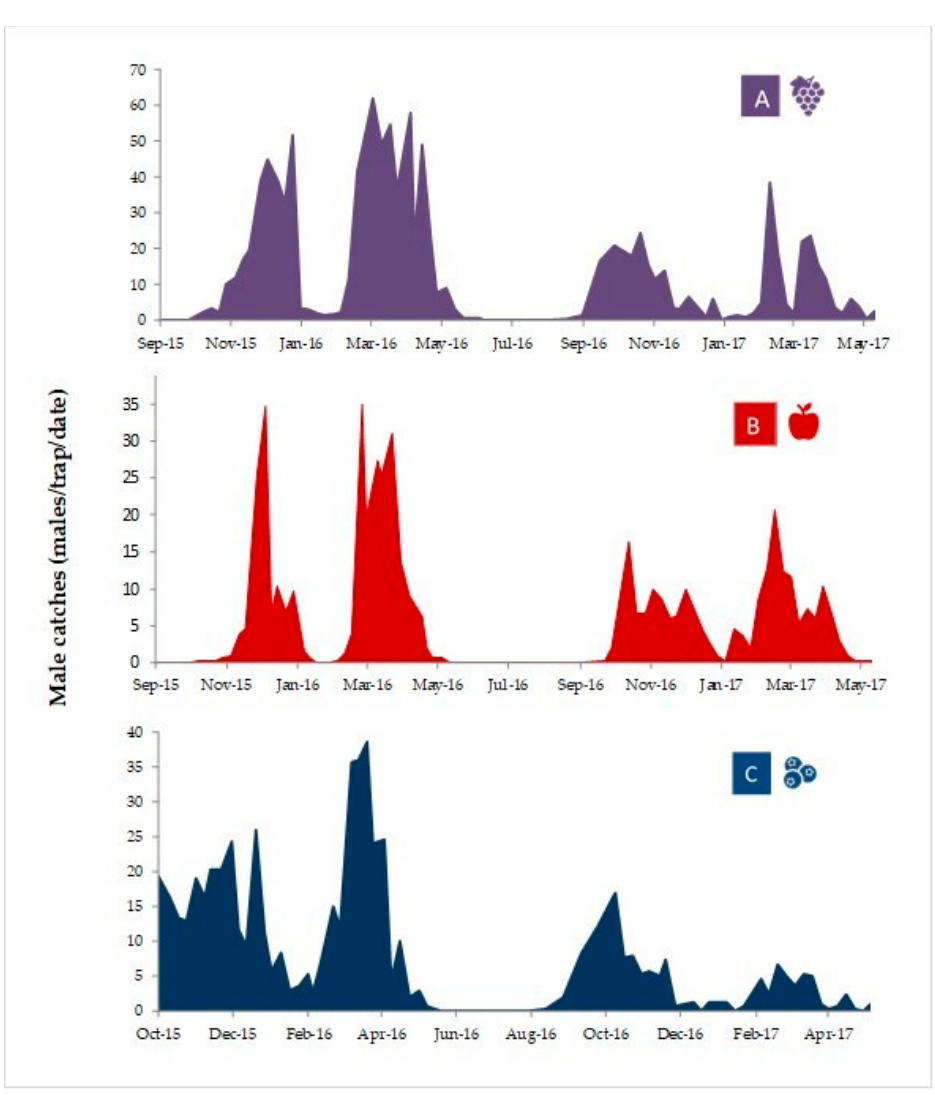
Figure 4. Captures of P. auraria (total males/3 delta traps/date) in a vineyard ( A : Requinoa), an apple orchard ( B : San Fernando), and a blueberry orchard ( C : San Francisco de Mostazal), all located in the O ´ Higgins region, central Chile, during two consecutive seasons (September ( A , B )/October ( C ) 2015 through May 2017), using septa loaded with 200 µ g of E11-14:OAc and 60 µ g of E11-14:OH. At harvest, no fruit damage was observed in blueberries. In the apple orchard, the percentage of damaged fruit was not significantly different between the MD plot